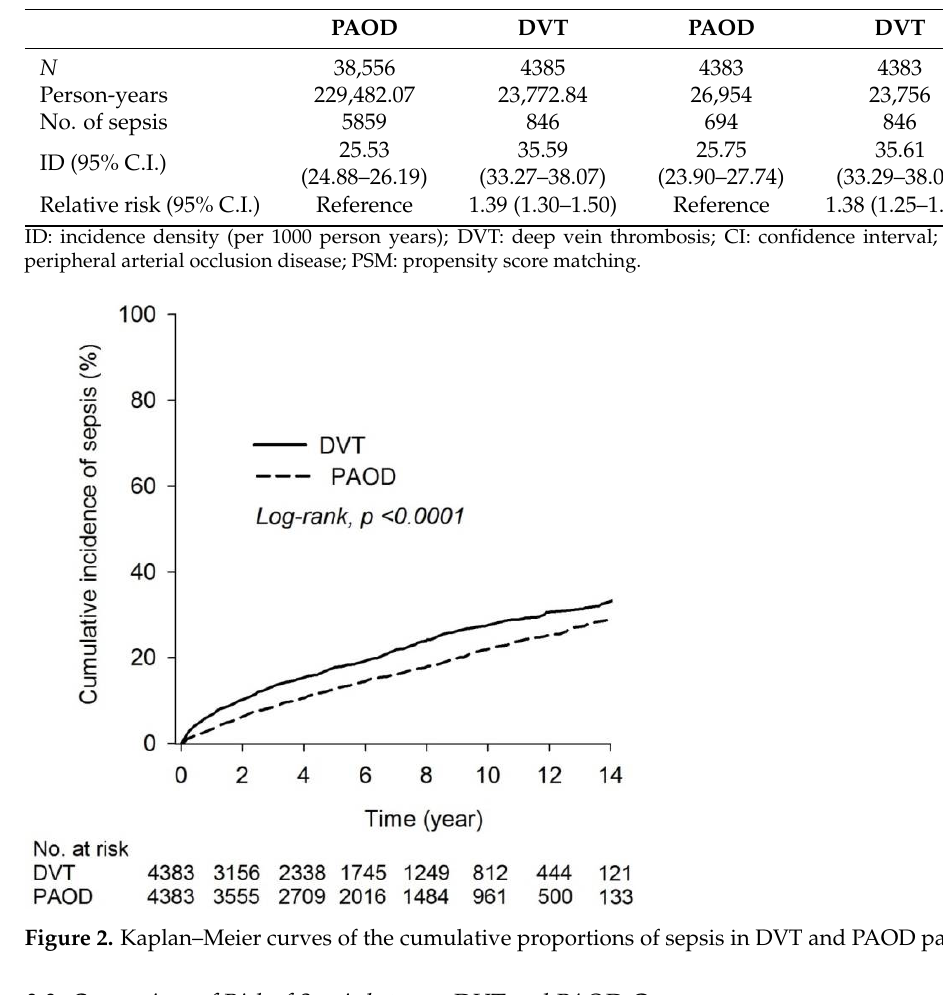
Table 3. Cox proportional hazard model analysis for risk of sepsis.